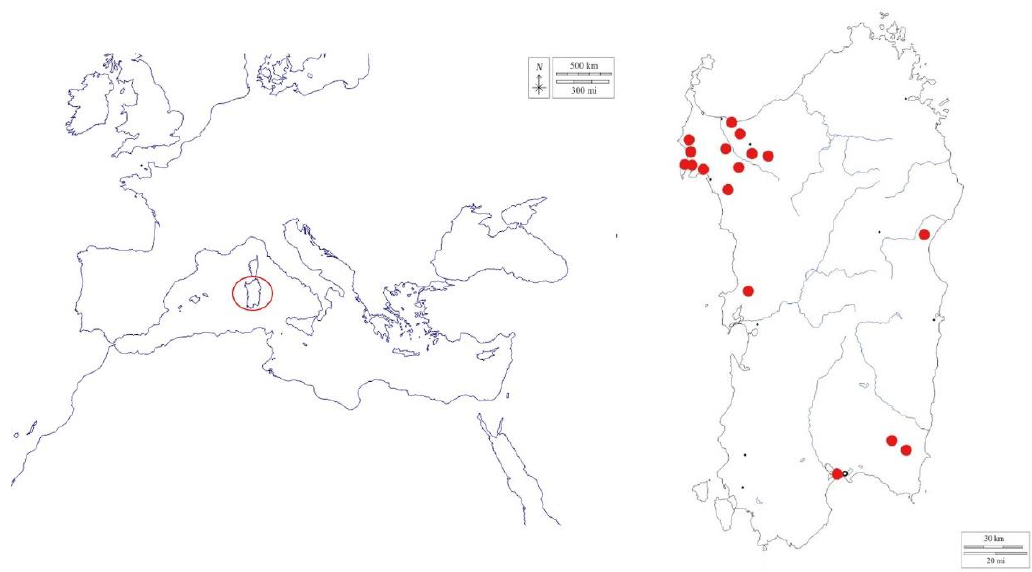
Insects 2021 , 12 , x 3 of 14